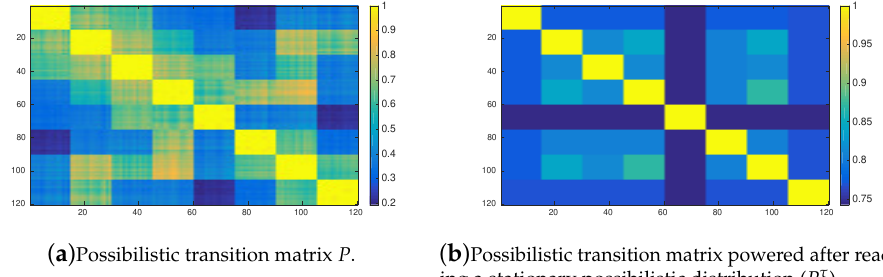
Figure 3. Possibilistic transition matrix induced by the OPRF with nTH = 2 for the 120 tasks arranged into 8